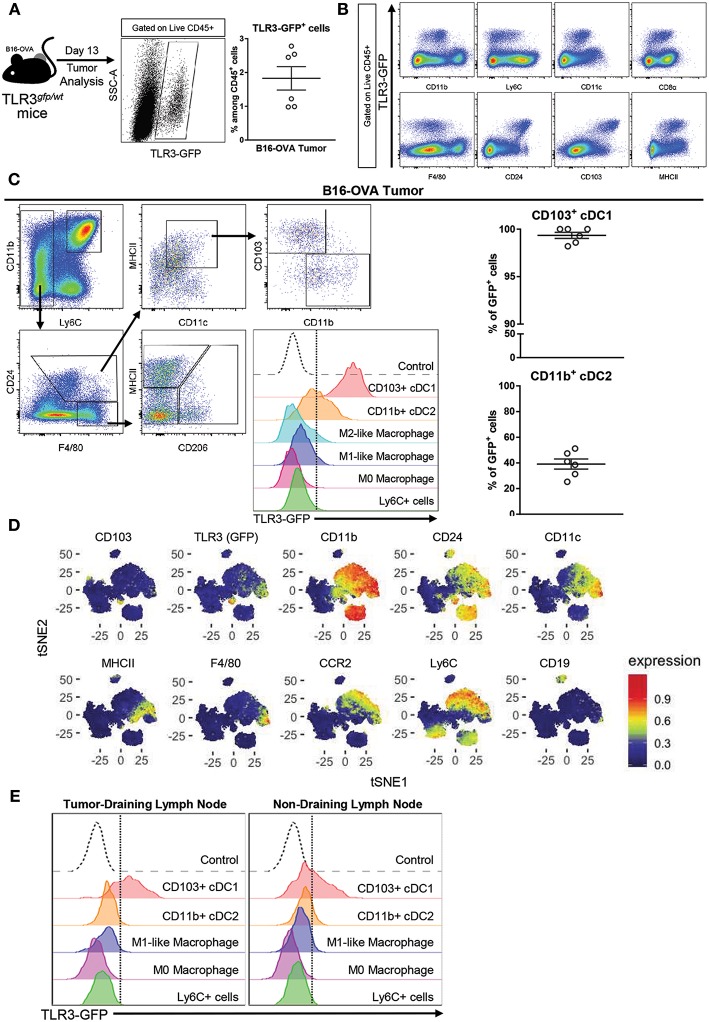
TLR3 is mainly expressed by CD103+ cDC1 and a fraction of CD11b+ cDC2. (A) Expression of TLR3-GFP on tumor-infiltrating leukocytes (CD45+ cells) isolated from B16-OVA tumors harvested from TLR3gfp/wt mice at day 13 after tumor cell inoculation. n = 6. (B) Intratumoral immune cells (Live CD45+ cells) from TLR3gfp/wt mice showing expression of TLR3-GFP together with different population markers. (C) Gating strategy used to characterize tumor-infiltrating myeloid cells. Expression of TLR3-GFP on different tumor-infiltrating myeloid cells (middle panel). Frequency of CD103+ cDC1 and CD11b+ cDC2 expressing TLR3-GFP among total cells in each population (right panel). (D) tSNE dimensionality reduction showing concatenated flow cytometry data of intratumoral immune cells from TLR3gfp/wt mice with heat-map showing the distribution of various surface markers on the different clusters. (E) Histograms showing TLR3-GFP expression on different myeloid cells present in tumor-draining and non-draining inguinal lymph nodes. Data in (A,C) are shown as mean ± SEM.